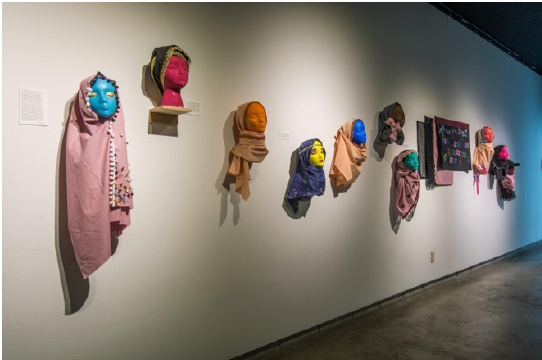
Figure 2. An overview of The Hijab Project at the Utah Museum of Contemporary Art.